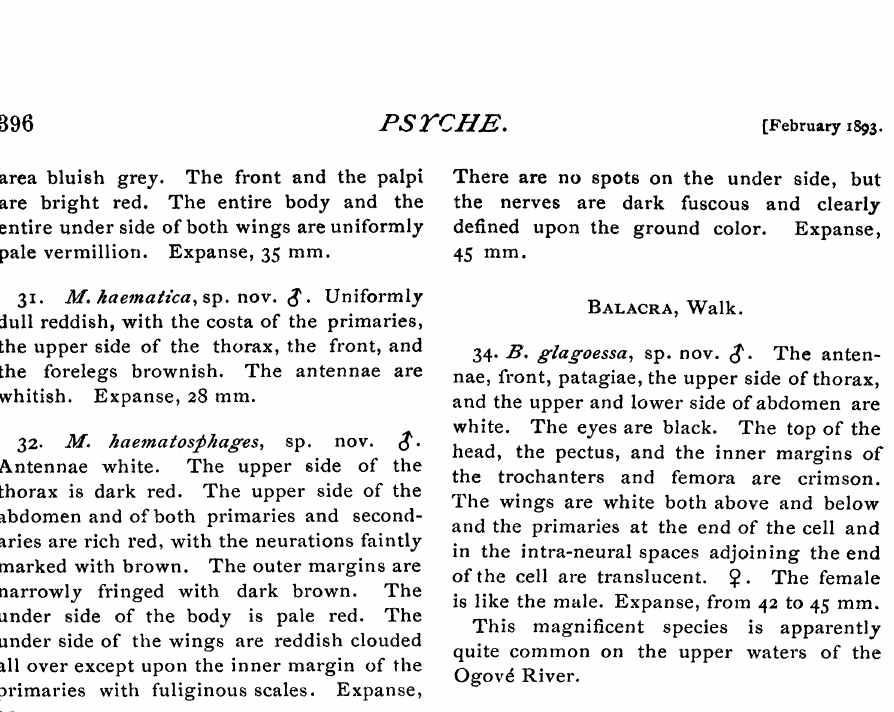
. . Anten- nae whitish. Head, palpi and upper side of thorax dark brown; abdomen reddish ochra. ceous. Uj3er side. The primaries are red thickly irrorated with fuscous. The fringes are fuscous. The wing is ornamented by five moderately large light red spots, one in the middle and another at the end ofthe cell, two smaller ones without the cell at the origin of the first median nervule. The secondaries are uniformly pale orange red. rnder side. The under side is a smoky brown except at the base and inner margin of both wings, which are pale